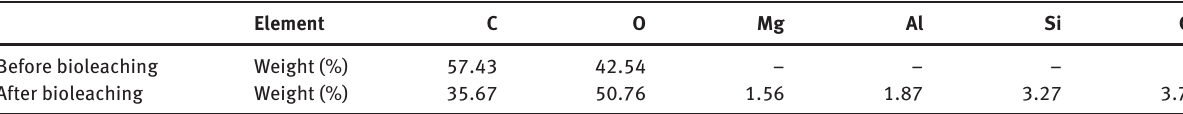
Table 4: EDX analysis of A. flavus (F3) biomass before and after